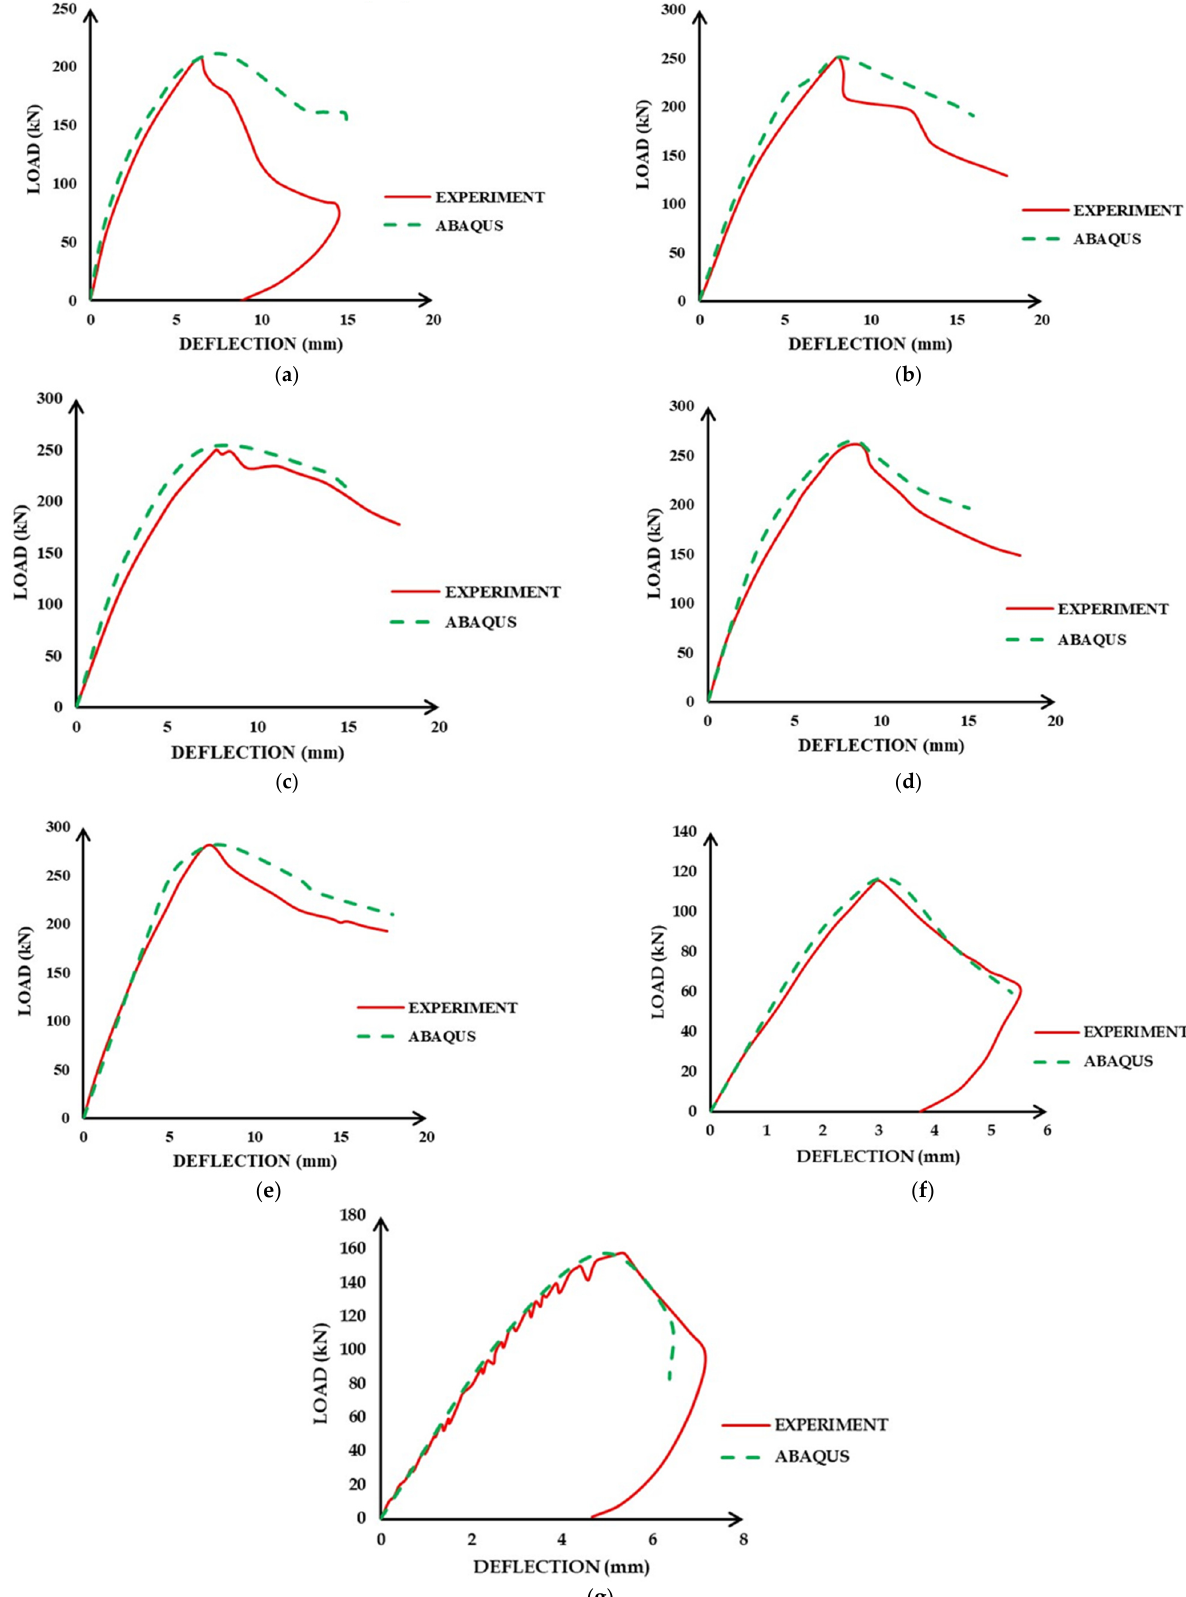
Figure 9. Response of ECC beams comparison under load and deflection: ( a ) P1, ( b ) P2, ( c ) P3, ( d ) P4, ( e ) P5, ( f ) P6, and ( g ) P7. ( e ) P5, ( f ) P6, and ( g )